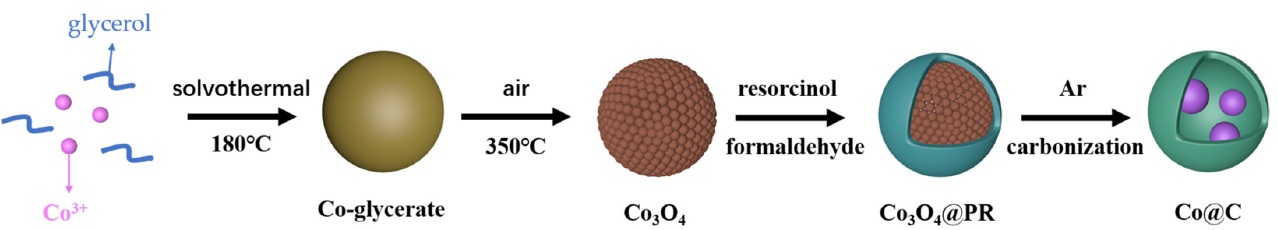
Figure 1. Schematic illustration of the synthetic strategy for multi-core yolk–shell Co@C nanospheres. XRD patterns of Co 3 O 4 , S1, S2 and S3 are shown in Figure 2. Co 3 O 4 nanospheres’ dif-